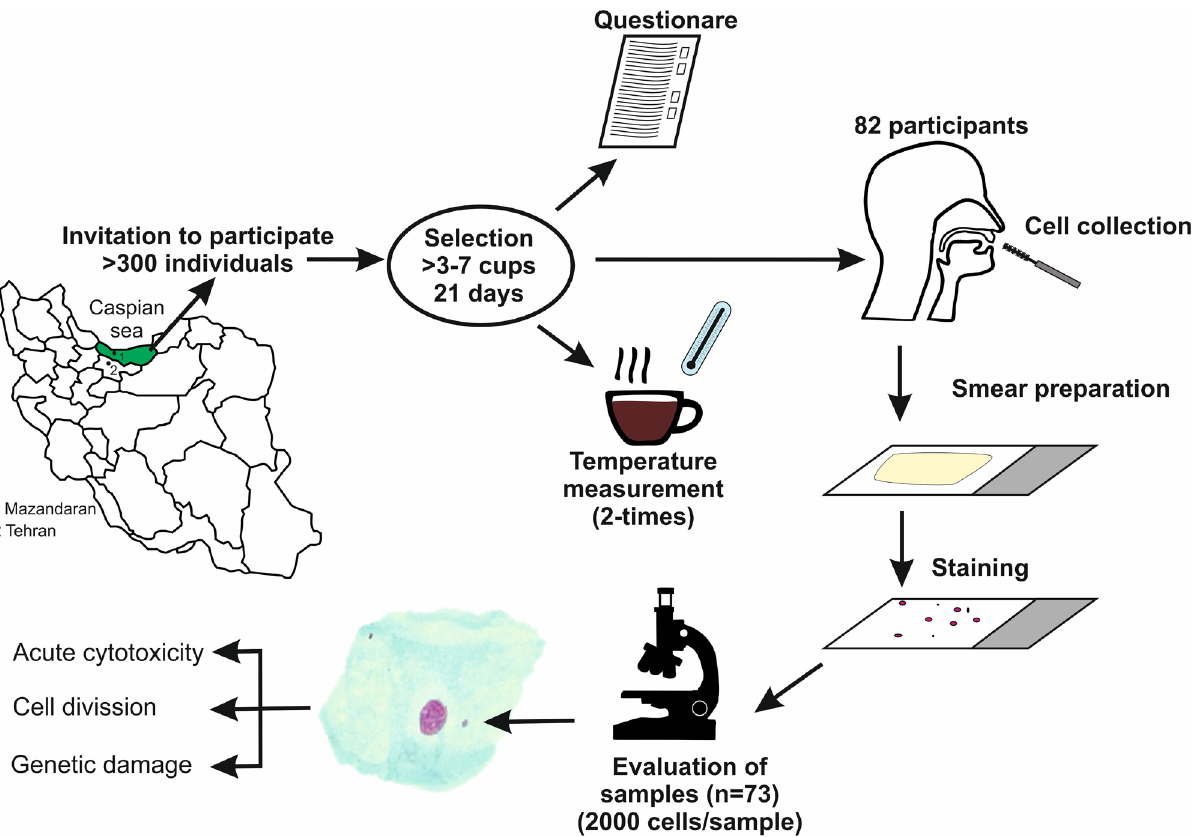
Figure 3. Schematic representation of the study design. More than 200 individuals were asked if they are willing to participate in the study; only those who were healthy non-smokers and consumed ≥ 3 cups of hot beverage daily over a period of 21 days were eligible. The participants filled in questionnaires concerning their lifestyle and demographic data. The temperature of the consumed beverages was measured twice with thermometers (at the start and end of consumption period). Mouth cells were collected with cytobrushes, fixed and stained and evaluated microscopically. We sampled in total 82 individuals, only slides from 73 subjects contained a sufficient number of cells for cytome